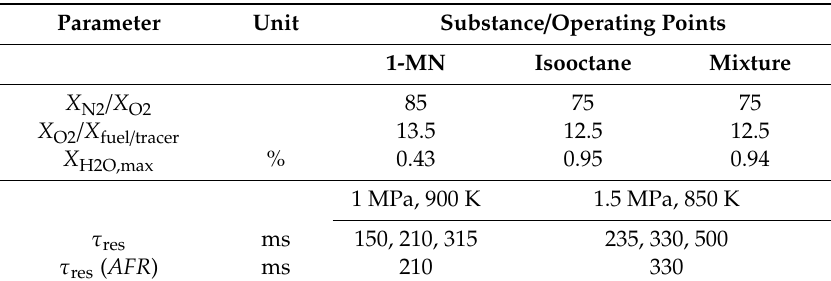
Table 1. Operating conditions of the flow cell.